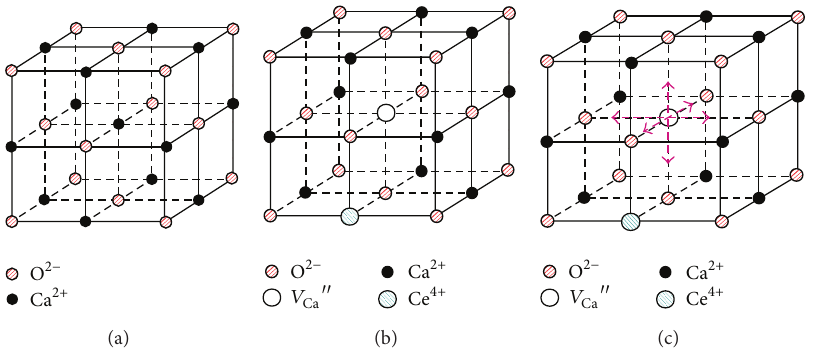
Figure 4: Schematic diagram for Crystal structure of CaO. (a) Crystal structure of CaO, (b) crystal structure of CaO doped with CeO 2 , and (c) schematic diagram for vacancy migration of Ca 2+